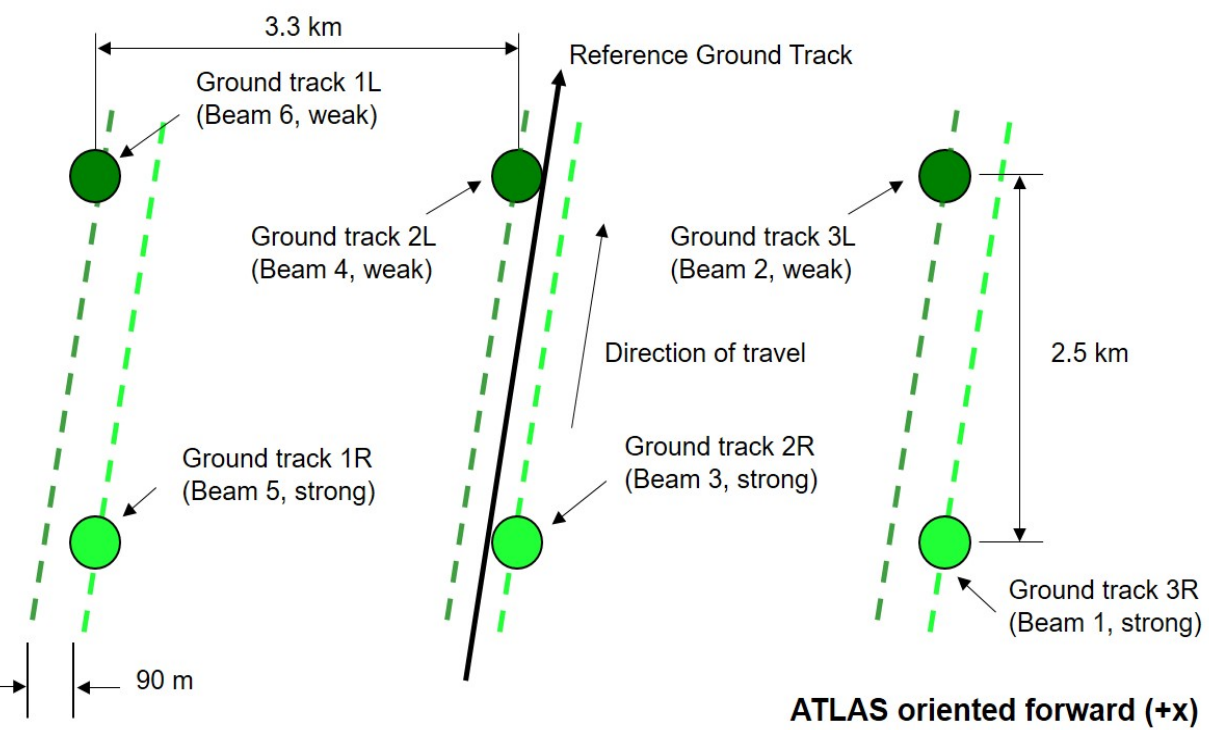
Figure 1. Schematic diagram of laser footprints of the Ice, Cloud, and land Elevation Satellite-2 (ICESat-2) on the ground in the forward orientation. The laser beam pattern is a 3 × 2 array in which one strong beam and one weak beam are grouped into a pair. When advanced topographic laser altimeter system (ATLAS) is oriented in the forward orientation, the weak beams are on the left side of the beam pair and are associated with ground tracks 1L, 2L, and 3L. When ATLAS is oriented in the backward orientation, the relative positions of weak and strong beams change, and the strong beams are on the left side of the ground track pairs and lead the weak beams [40]. The distance between each pair was approximately 3.3 km. In the same pair, the interval between the strong beam and the weak beam was 2.5 km. The cross-track distance between the two ground tracks in the same pair was 90 m.